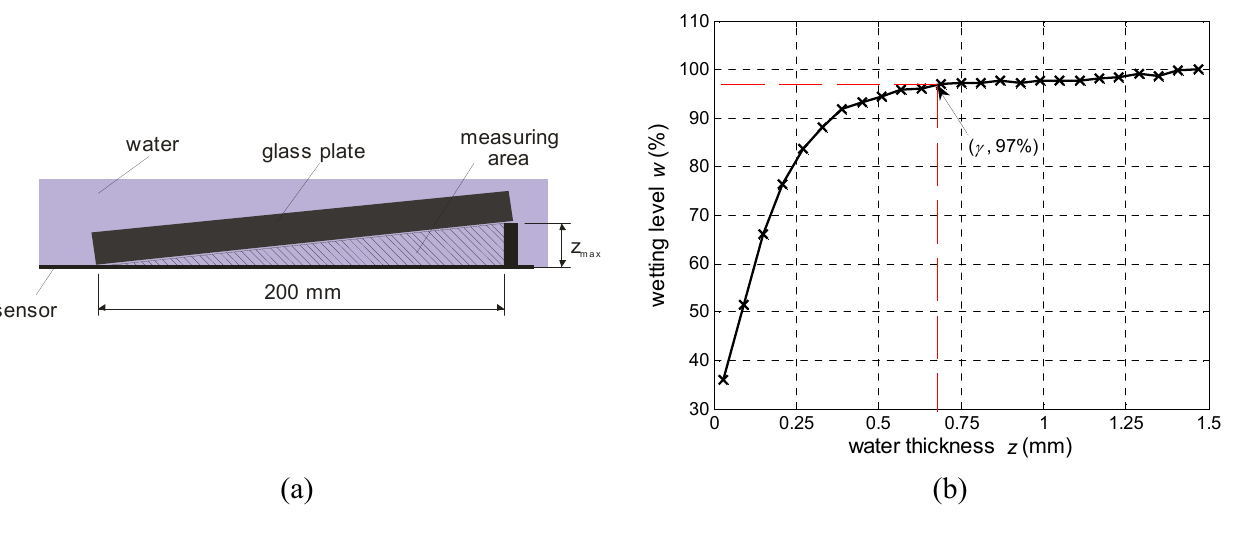
Figure 5 . (a) Experimental setup for the depth sensitivity estimation. (b) Wetting level response for different water thickness over the sensor